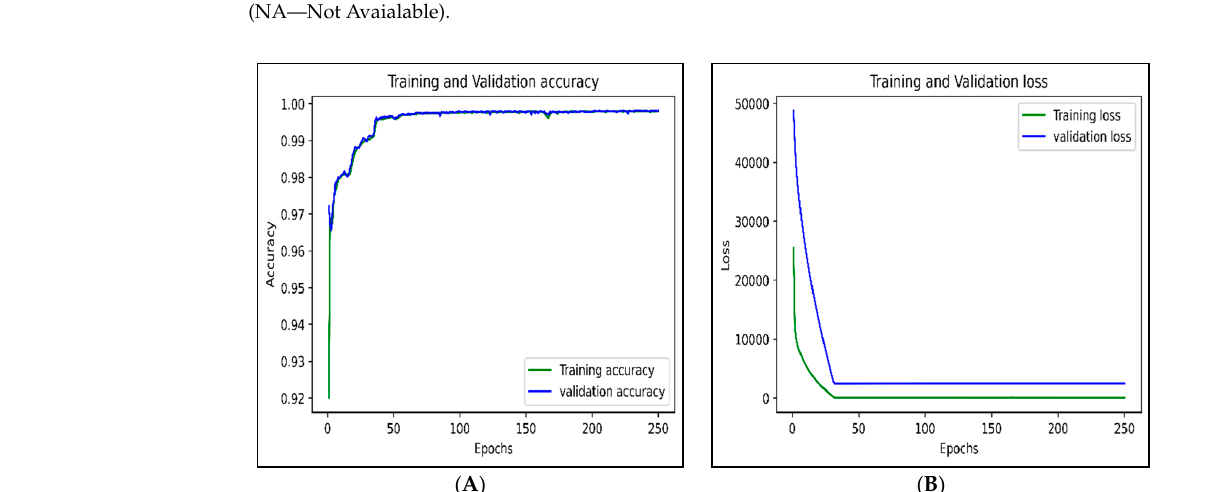
Electronics 2022 , 11 , 3529 Figure 15. ( A,B ): Accuracy and Loss curves for Tuesday sub-dataset. Figure 15. ( A , B ): Accuracy and Loss curves for Tuesday sub-dataset.